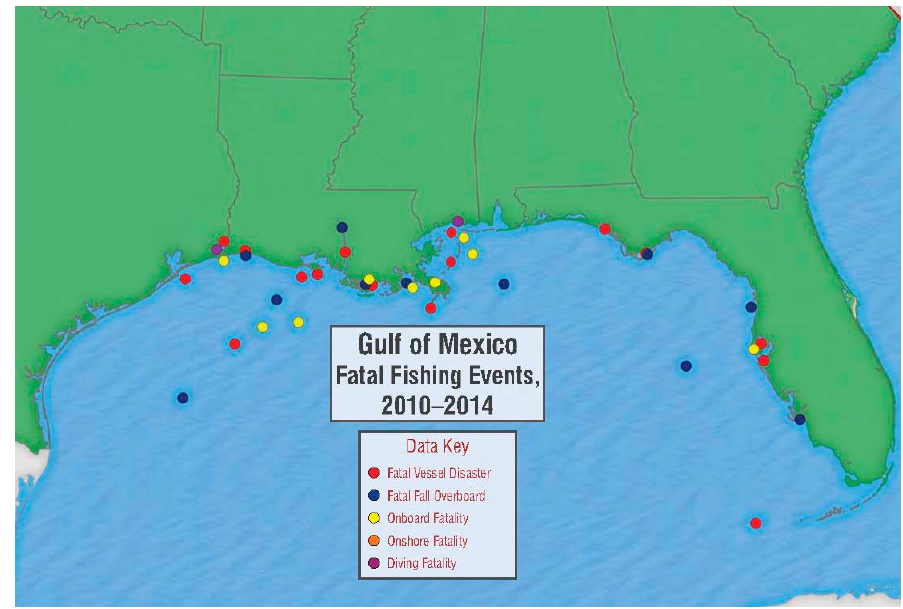
Figure 1. A map depicting the US Gulf of Mexico waters and the types of fatalities of fish harvesters there. Source: Syron et al., 2017 [3], Courtesy National Institute for Occupational Safety and Health (NIOSH), open access.